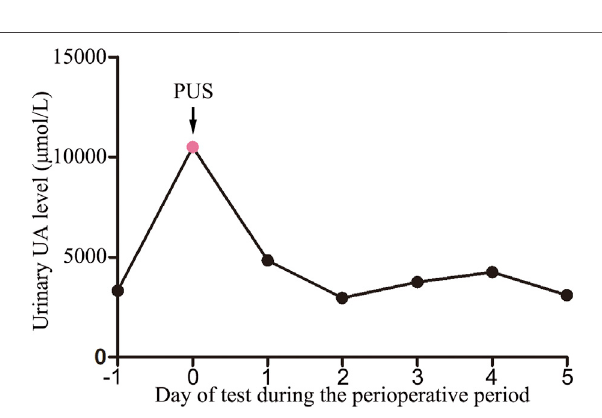
FIGURE 3 | Urinary uric acid levels during the perioperative period ( − 1: before surgery; 0: urinary drainage bag; 1 – 5: days after surgery). PUS: Pink Urine